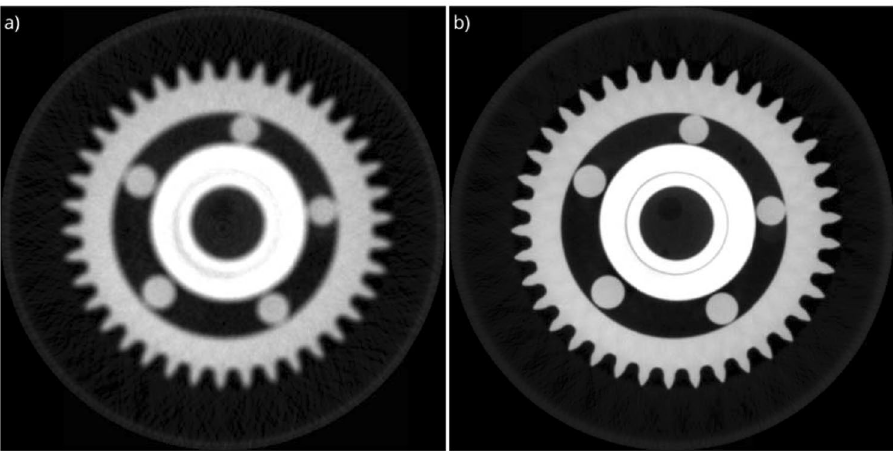
Figure 6. The reconstruction results of the ball bearing. For the reconstruction, the motion compensation module is ( a ) disabled, and ( b ) enabled. The motion is estimated applying the proposed deep-learning based feature tracking method, and the image is reconstructed by considering calculated shifts on the detector plane.